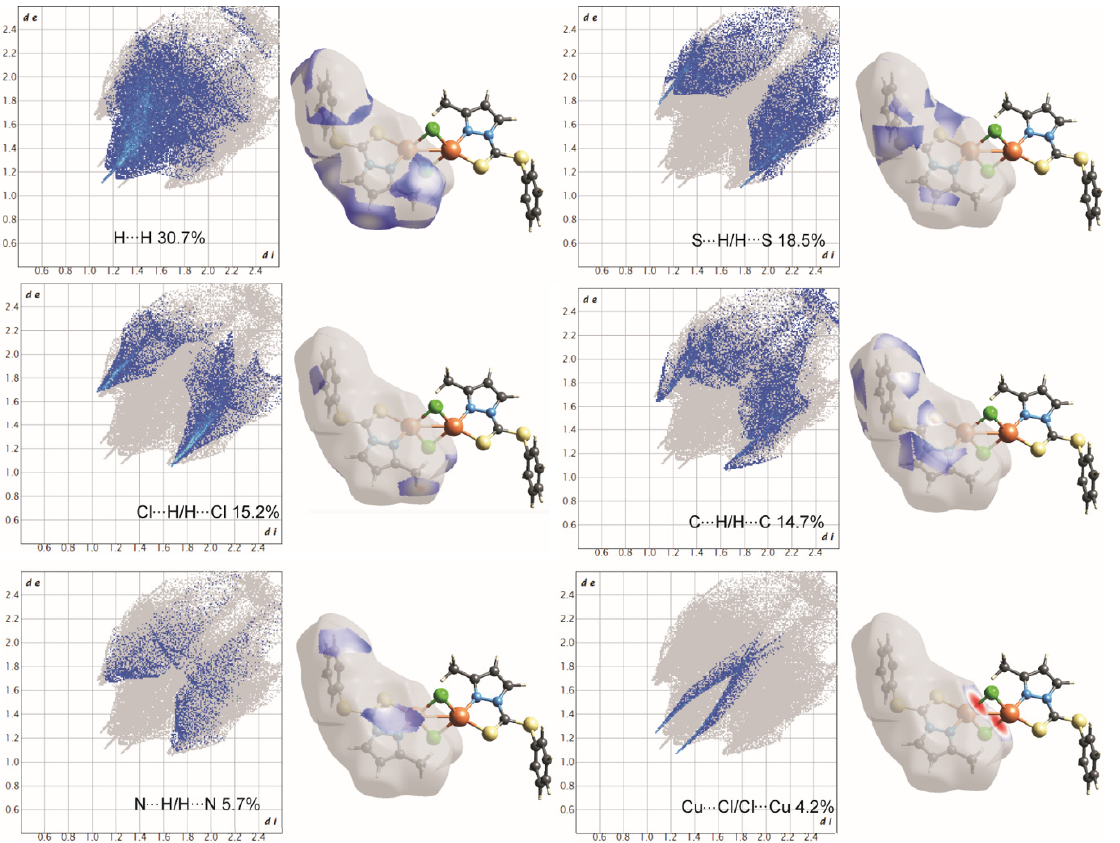
Figure 8. 2D-fingerprint plots for all intermolecular contacts in complex 2 . The percentage of contribution for each contact is specified as shown at the bottom of each subfigure.